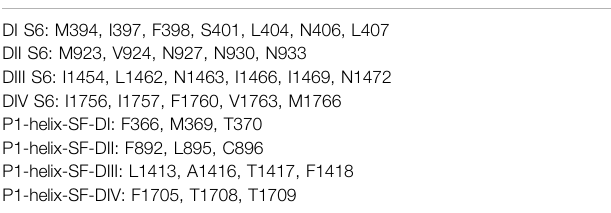
TABLE 1 | Amino acids that form the fenestrations in